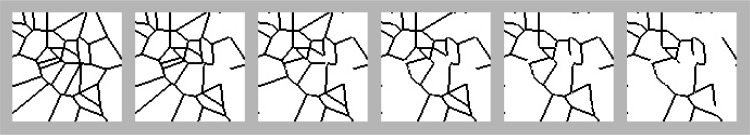
Illustration of how hedgerows were removed from the landscape.The left hand panel shows a 101 × 101 cell landscape generated using 30 randomly placed field seeds, where white cells represent agricultural crops and black cells represent wild land or hedgerows. Hedgerows are removed by randomly selecting adjacent fields, and removing the cells between them that were initially designated as hedgerows. Moving from left to right, each successive panel has four additional hedgerows removed.